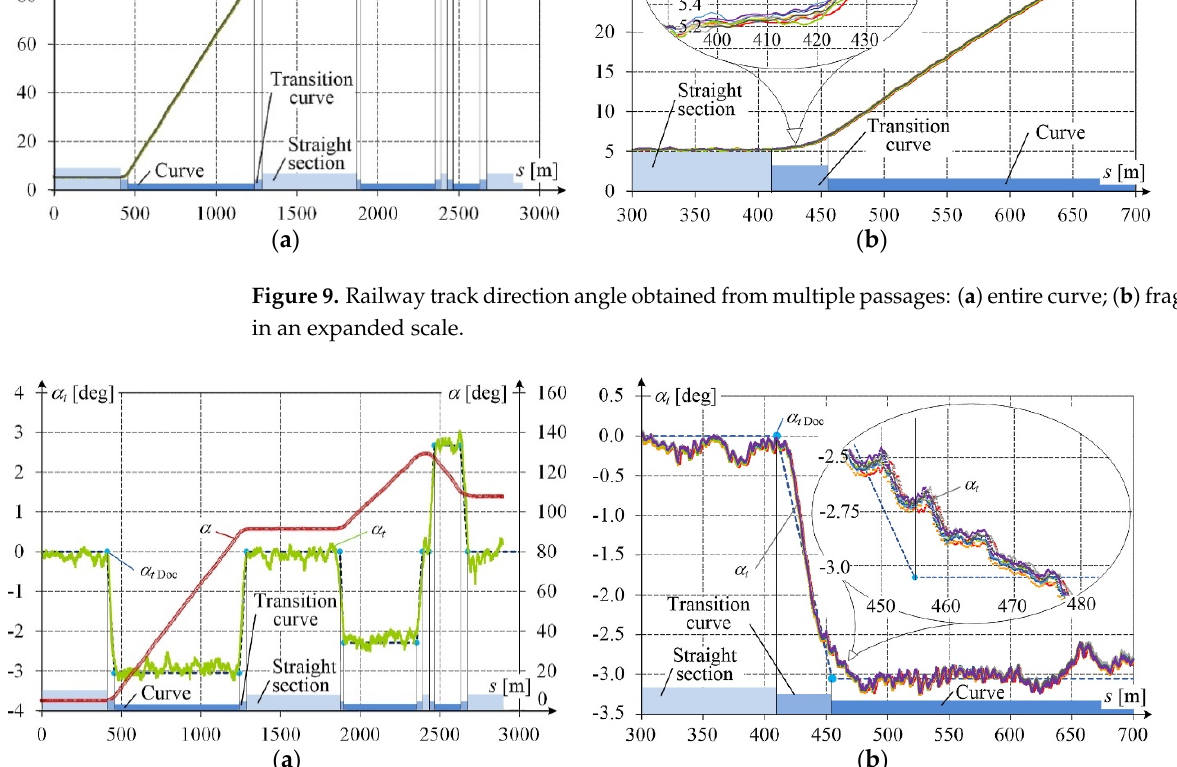
Figure 10. Direction and lateral inclination angle of the track: ( a ) direction angle α from INS, and lateral inclination angles: α t from measurement and α t Doc from documentation, with indicated types of railway track sections; ( b ) in expanded scale from multiple passages.